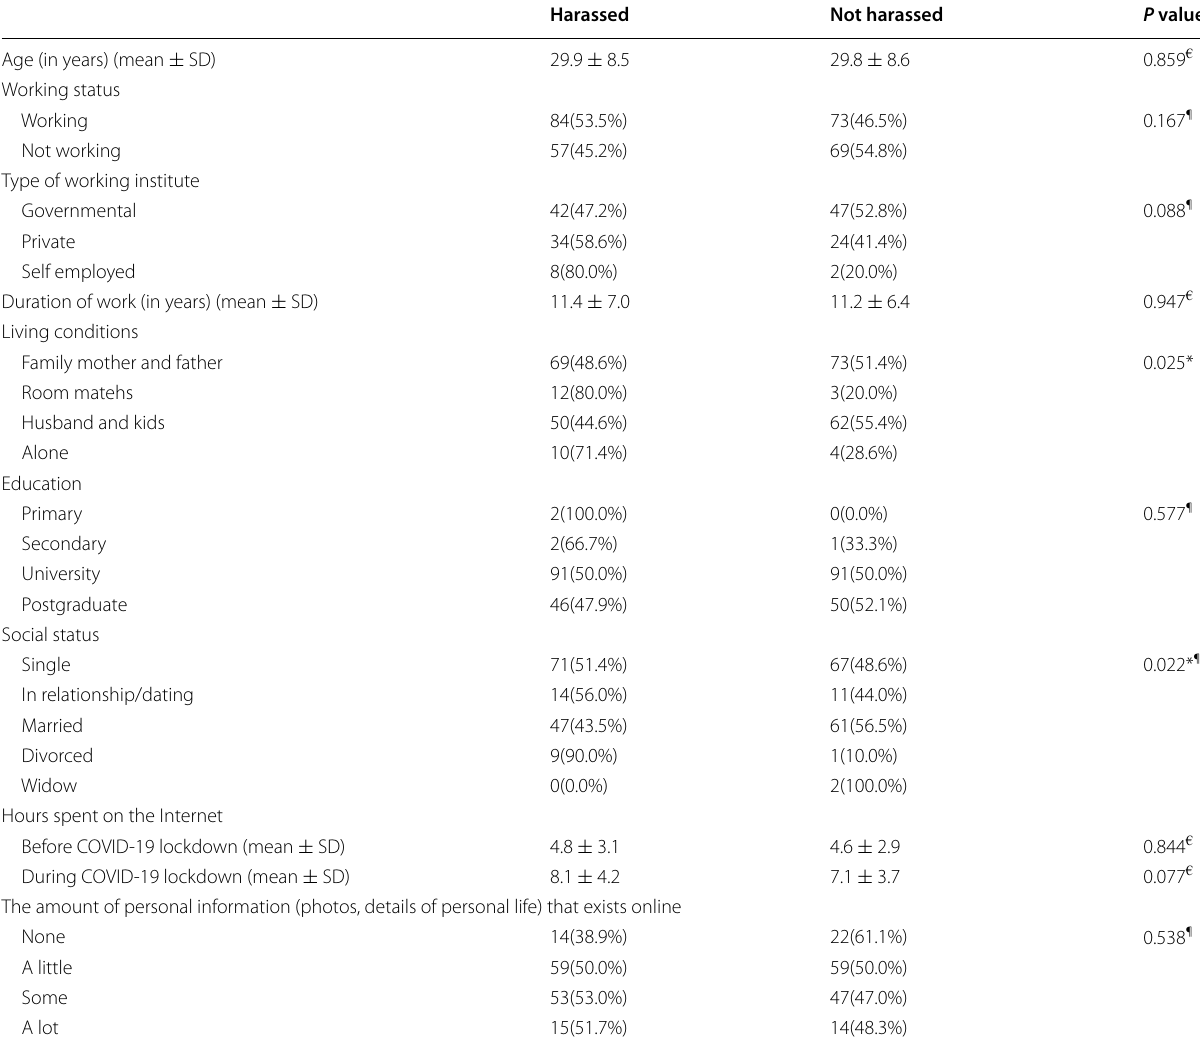
Table 7 Relation between digital harassment and sociodemographic characteristics of the harassed study participants ( n